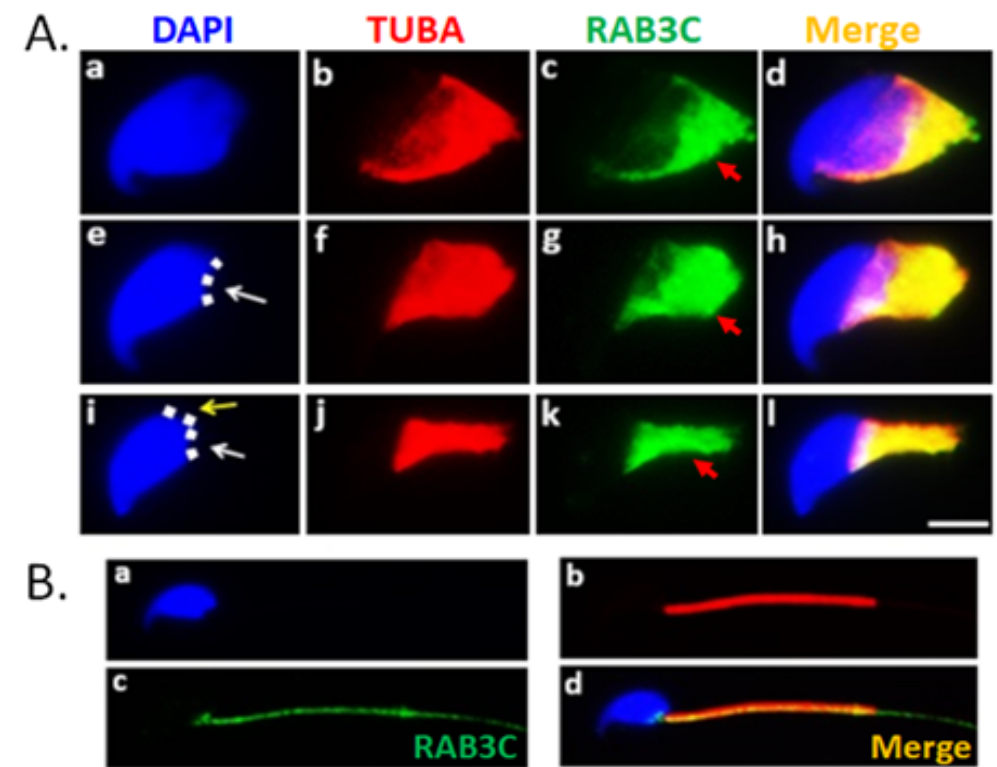
Figure 3. Dynamic localization of RAB3C during murine spermiogenesis. ( A ) Localization of RAB3C proteins in elongated spermatids during murine spermiogenesis. Sperm samples were stained with DAPI (nucleus, blue), and anti-TUBA (red) and anti-RAB3C (green) antibodies. The figures on the left indicate sperm head morphology at various stages. White and yellow arrows indicate ventral and dorsal angles, respectively. And, red arrows indicate RAB3C signals. The dotted lines indicate the sites of the angles. Spermatids at ( a – d ) step 7–9, ( e – h ) ventral angles at step 10, and ( i – l ) ventral and dorsal angles at step 11 during murine spermiogenesis. ( B ) RAB3C signals (green) are remarkably colocalized with MitoTracker (red) in the midpiece and postacrosomal regions of the mature sperm. (Magnification: 400 ×